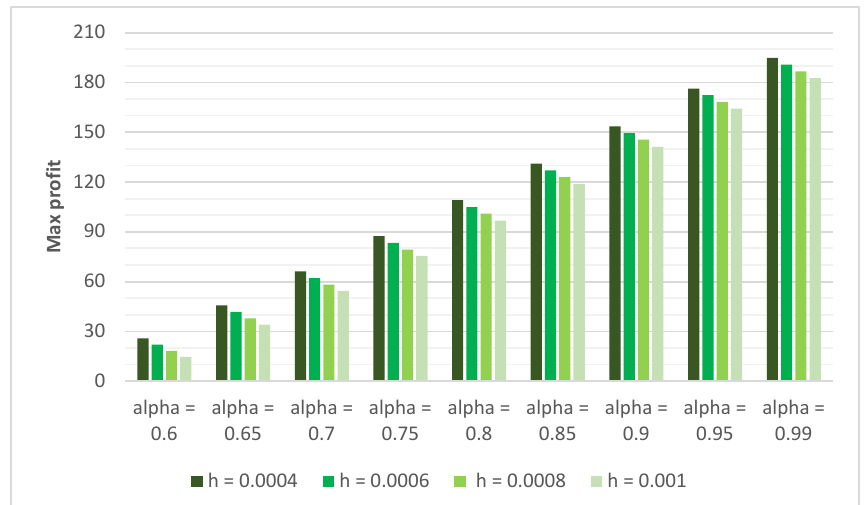
Fig. 7. Maximum profit, double demand with stockholding